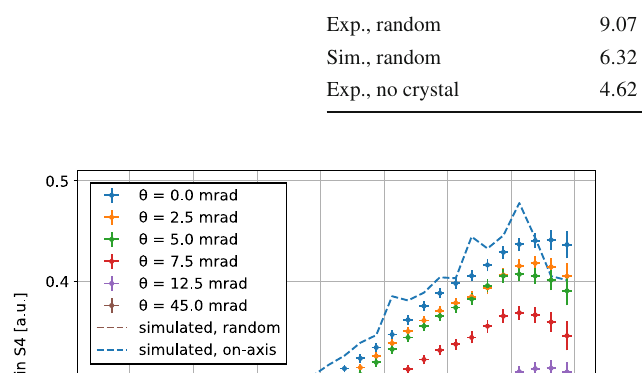
Table 1 Missing energy (i.e., part of the initial photon energy not detected by the γ -CAL) at different angles between the beam and the (cid:2) 111 (cid:3) axis, for different values of the tagged photon energy. Errors are reported in parentheses